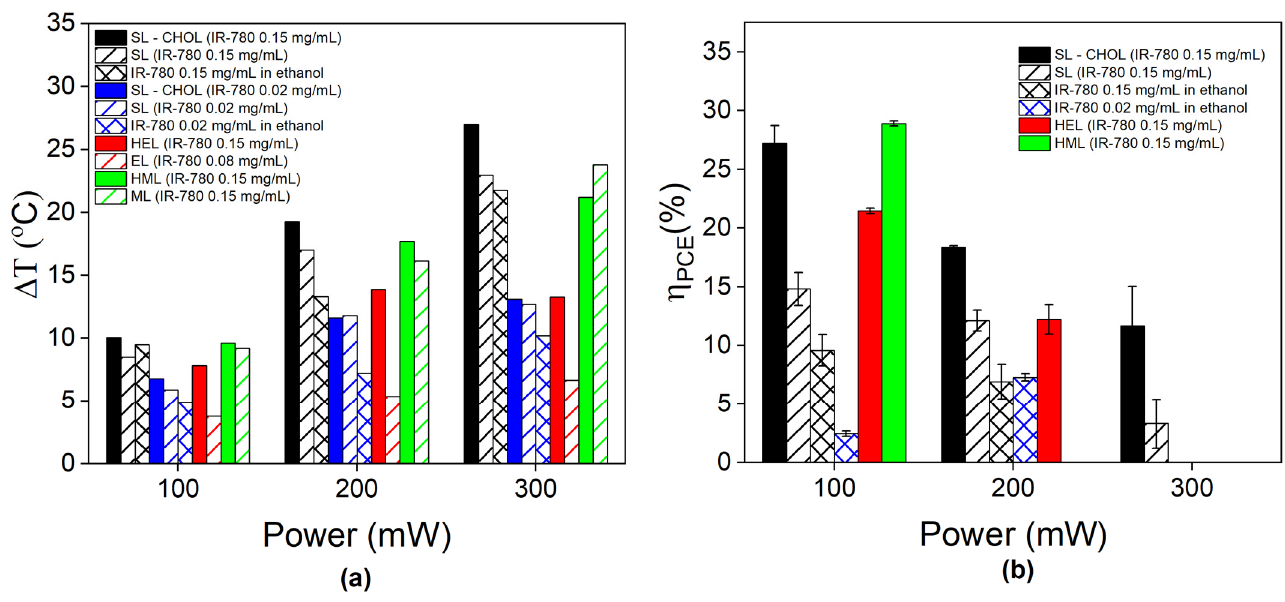
Figure 5. Photothermal efficiency: ( a ) Maximum temperature variation during PTT at different laser powers (100, 200 and 300 mW) for free IR-780, SLs, SL-CHOL, ELs, MLs, HELs and HMLs. A few samples show data for different amounts of IR-780. ( b ) Photothermal conversion efficiency (PCE) calculated using Roper´s method in different laser power conditions for free IR-780, SLs, SL-CHOL, HELs, and HMLs. Samples that show photobleaching were not considered in PCE calculations.